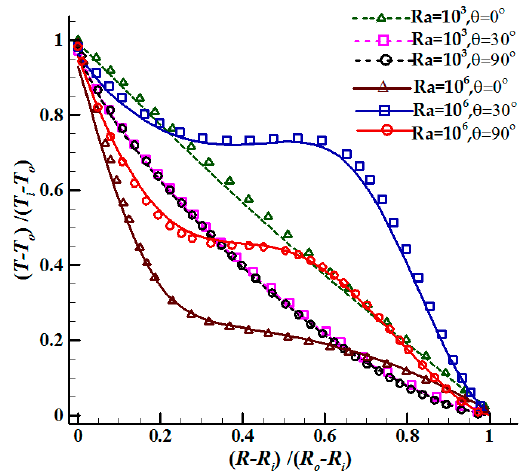
Figure 8. Temperature distribution along the gap between the inner and outer hexagonal cylinders at angular directions, θ = 0 ◦ , θ = 30 ◦ , and at θ = 90 ◦ for AR = 0.6. The symbols represent corresponding data from Fluent software.